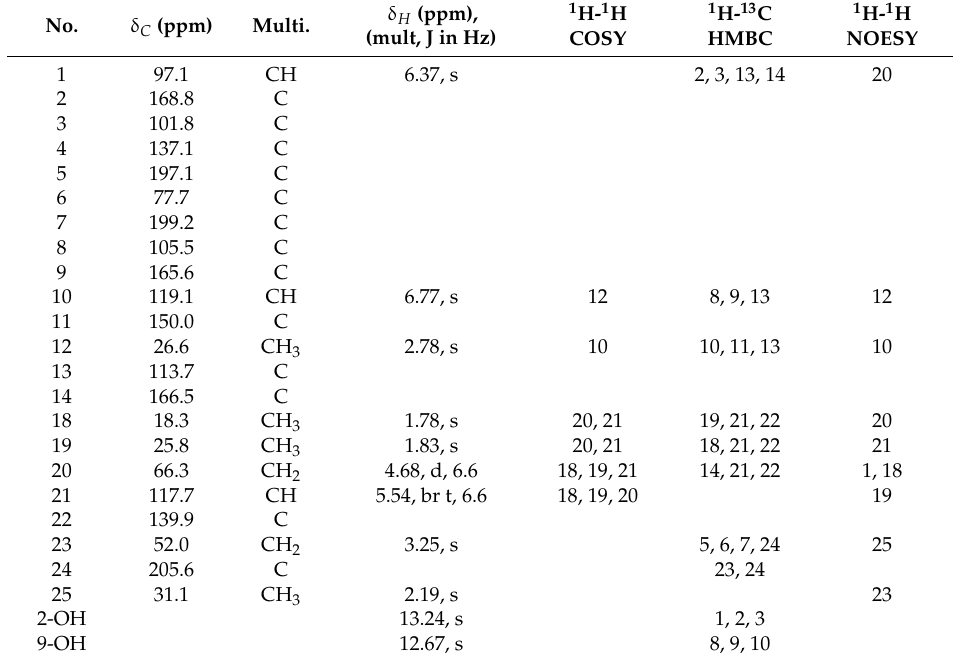
Table 3. NMR (CDCl 3 ) spectroscopic data for 4a.